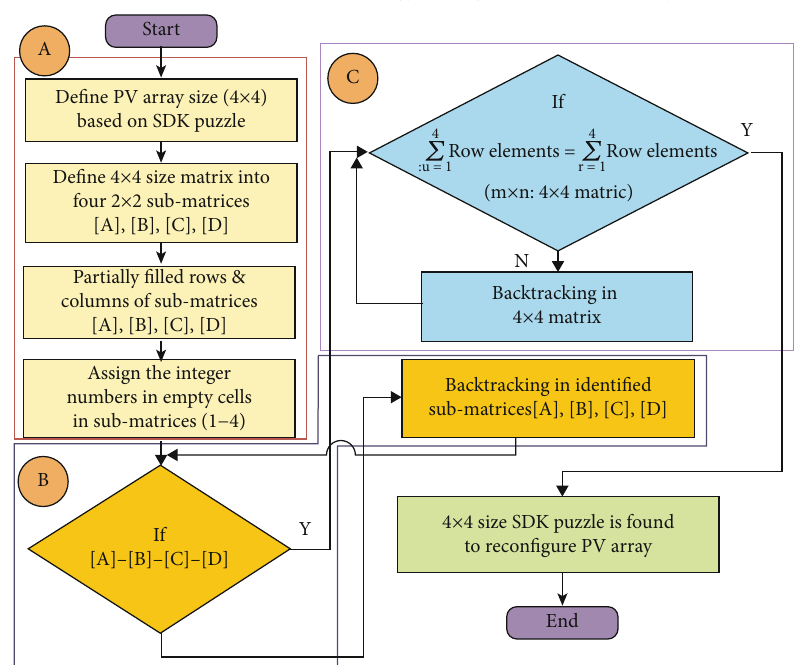
(l) Flow chart for SDK methodology to design 4 × 4 size of PV array Figure 12: